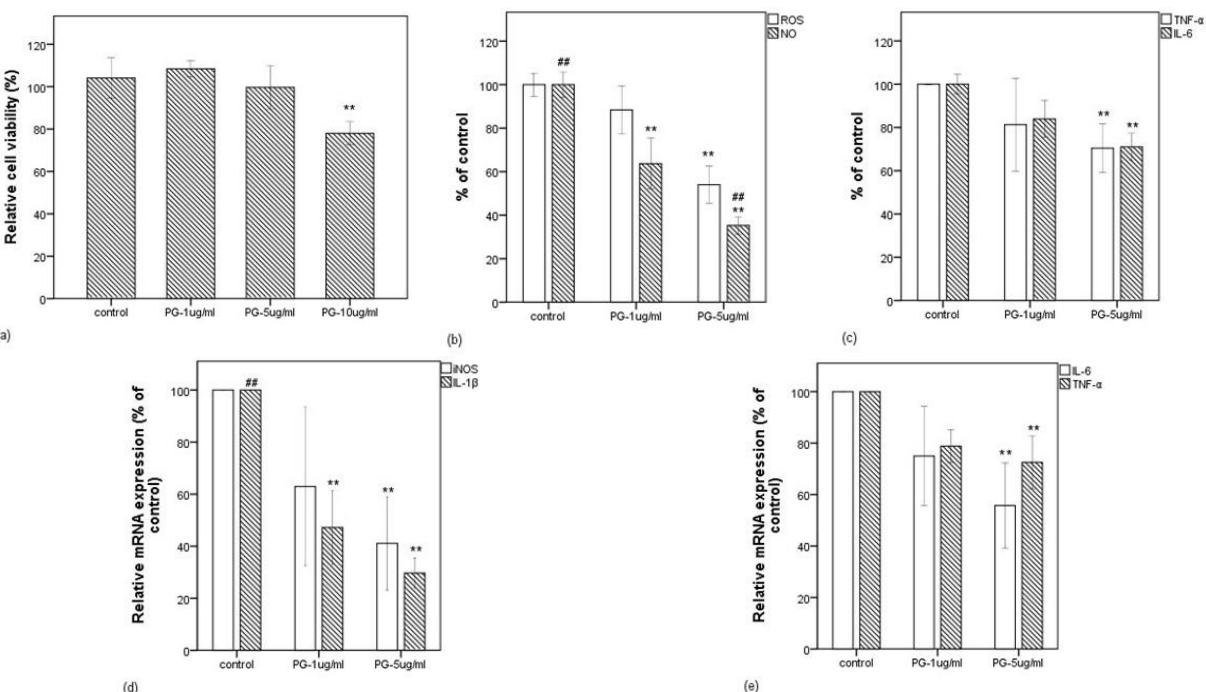
Figure 5. Effect of pyrogallol on LPS-induced RAW 264.7 cells. ( a ) Relative cell viability when RAW 264.7 cells were treated with LPS in the presence of pyrogallol at 1, 5, and 10 µg/mL. ( b ) Effect of pyrogallol at 1 and 5 µg/mL in intracellular ROS and NO release levels (in % of control) in LPS-stimulated RAW 264.7 cells. ( c ) Effect of pyrogallol at 1 and 5 µg/mL in IL-6 and TNF- α release levels (in % of control) in LPS -stimulated RAW 264.7 cells. ( d ) Effect of pyrogallol at 1 and 5 µg/mL in mRNA expressions of iNOS and IL- 1β (in % of control) in LPS -stimulated RAW 264.7 cells. ( e ) Effect of pyrogallol at 1 and 5 µg/mL in mRNA expressions of IL-6 and TNF- α (in % of control) in LPS -stimulated RAW 264.7 cells. Data are expressed as the mean value of at least triplicate experiments. Error bars represent +/ − standard deviation. ** p < 0.01 versus control, ## p < 0.01 versus PG-1 µg/mL. PG: pyrogallol.